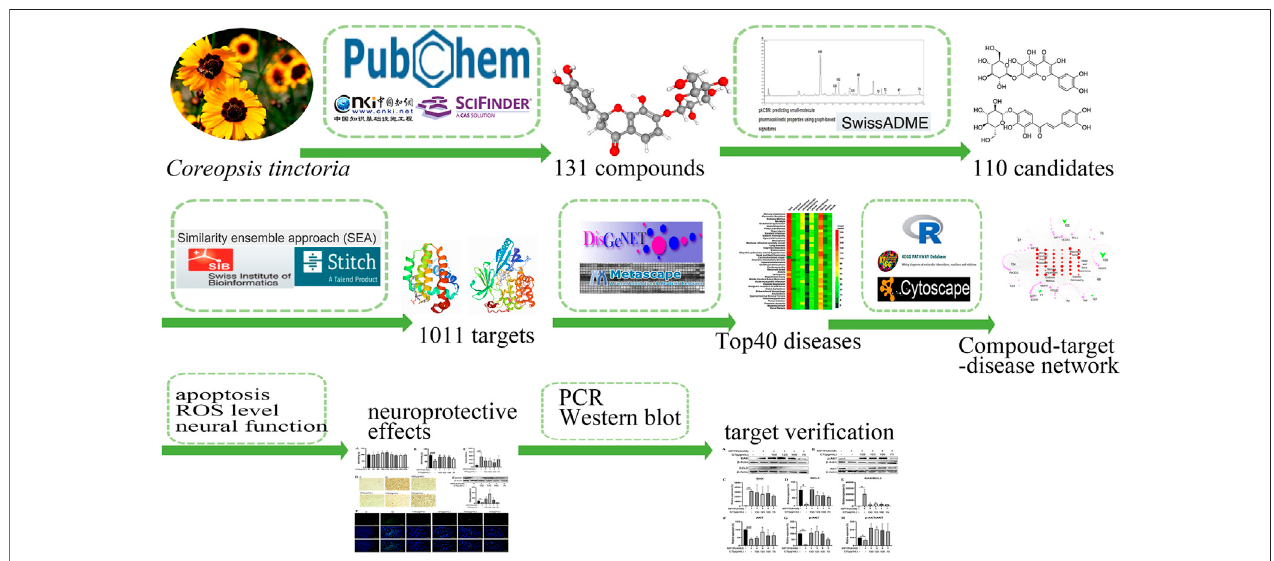
FIGURE 1 | The strategy and work fl ow of this